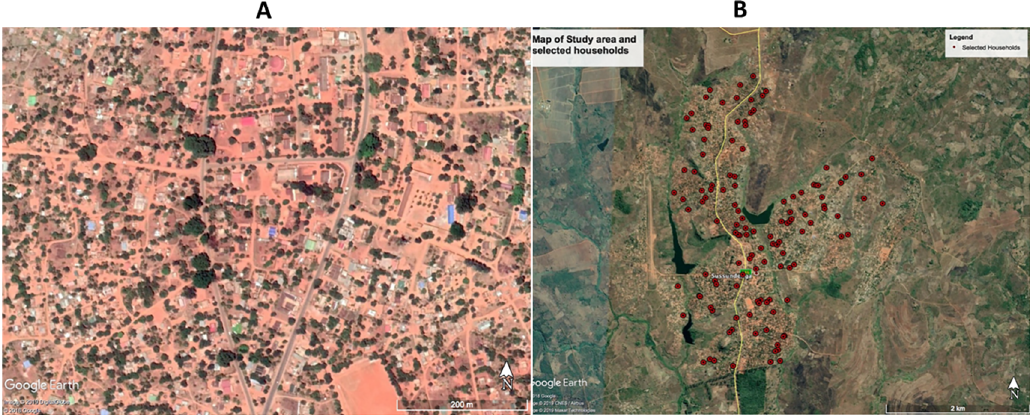
Figure 2. A. High-resolution imagery of Sussundenga village from Google Earth Pro TM (Google Earth, 2019 Google image, 2019 CNES/Airbus, image 2019 Maxar Technology). B. Selected households from Google Earth Pro TM17 (Google Earths Image 2019 Terra metrics, 2019,